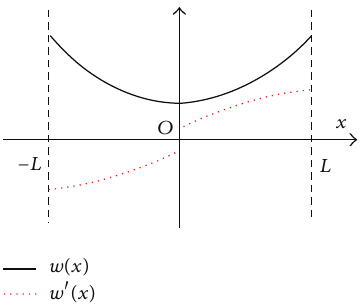
Figure 4: An illustration of the possible discontinuities of the displacement and its derivative at the end